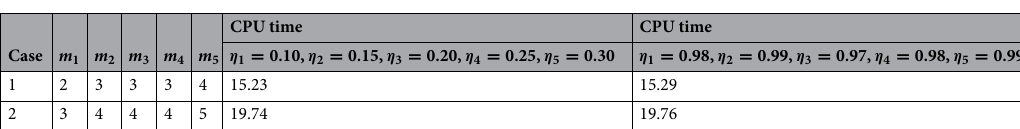
Table 2. The runtime (in seconds) of the proposed method with different choices of m i , i = 1, 2, 3, 4, 5 , for Example 1.